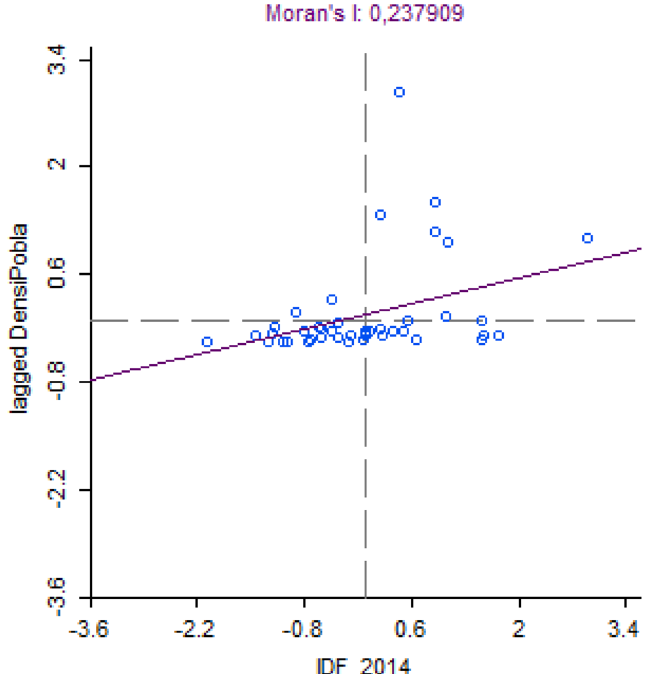
Fig. 8 Global Moran Index for the fiscal efficiency (IDF_2014) and the categorization of the area (by population density). Source: own computation based upon GeoDa